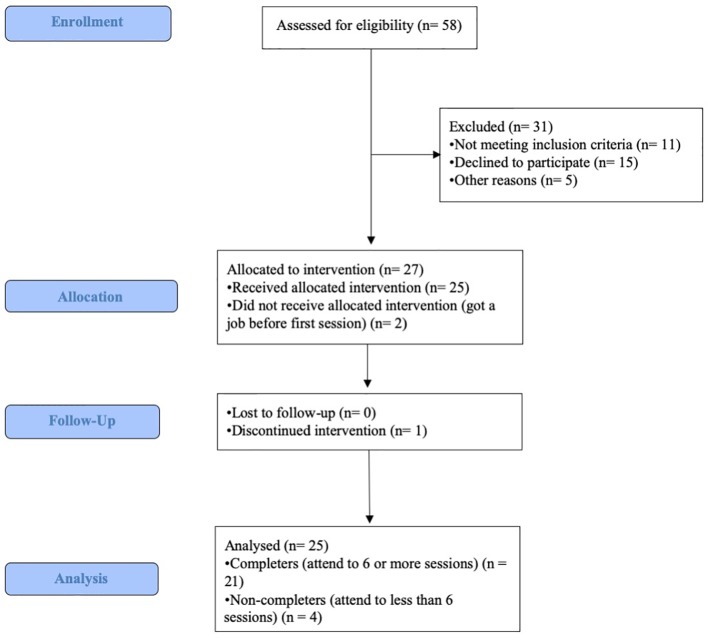
CONSORT flowchart.